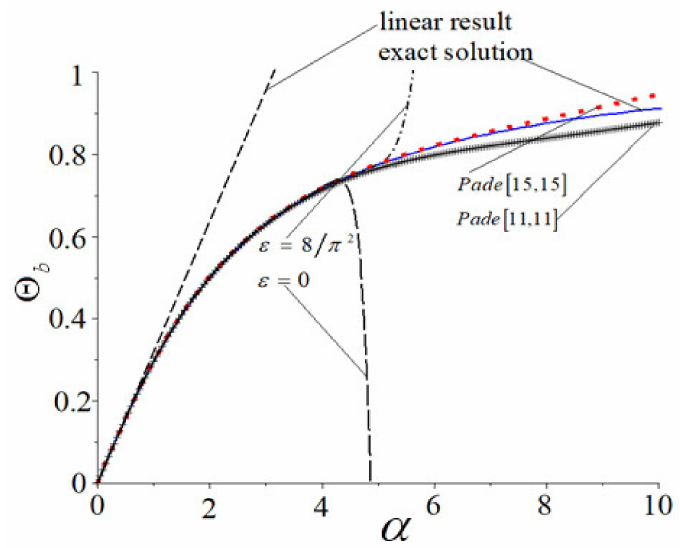
Figure 4. Thirieth solution to rotation angle at the free end vs. point